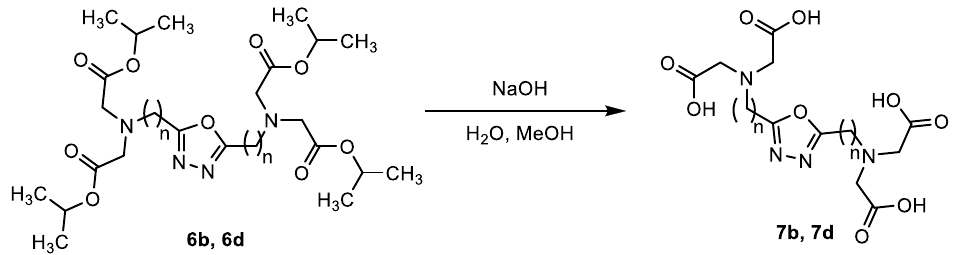
Table 4. Obtained yields of 2,5-dialkyl-1,3,4-oxadiazole ( 6a-e ) and products of their hydrolysis con- taining carboxylic groups ( 7b , 7d